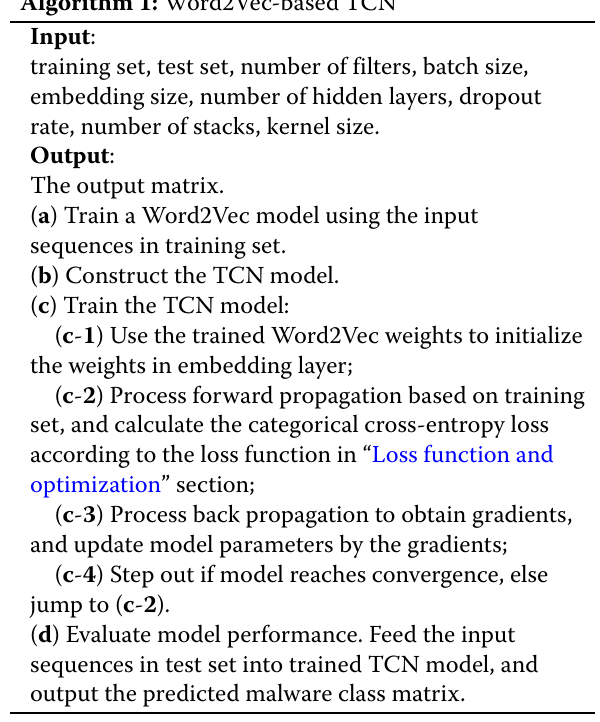
Algorithm 1: Word2Vec-based